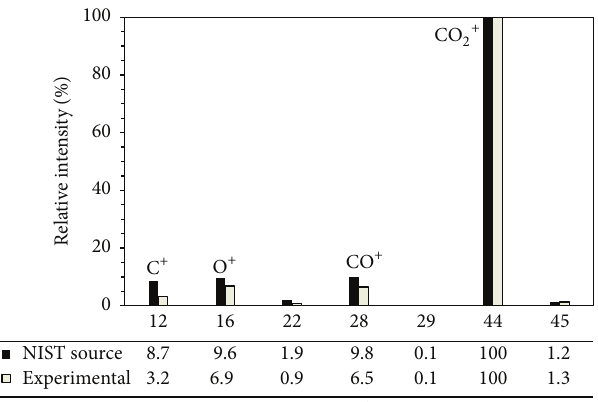
Figure 4: Pure CO 2 mass spectrum obtained experimentally and its relative ion intensities. Reference values from NIST Chemistry WebBook [18] are shown for comparing.